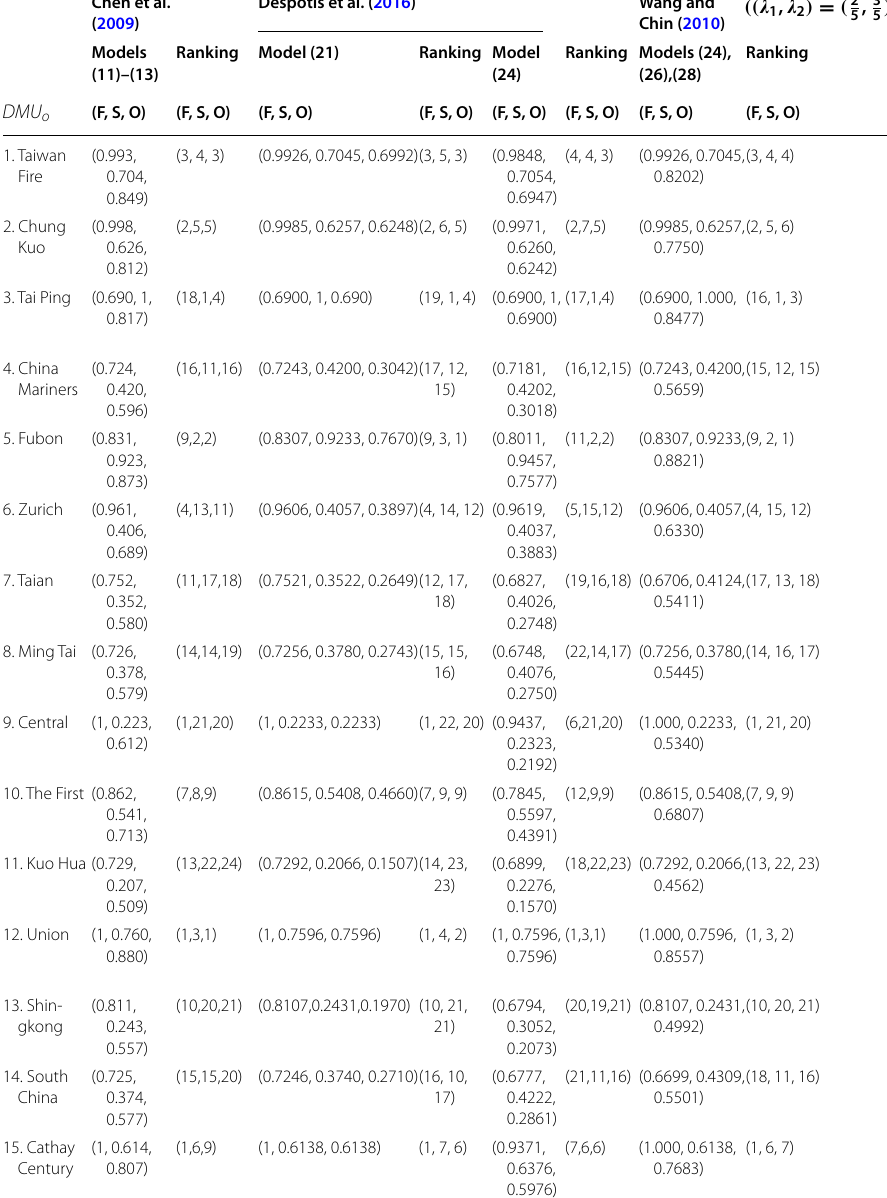
Table 10 Example 3. Results from Chen et al. (2009), Despotis et al. (2016) and Wang and Chin